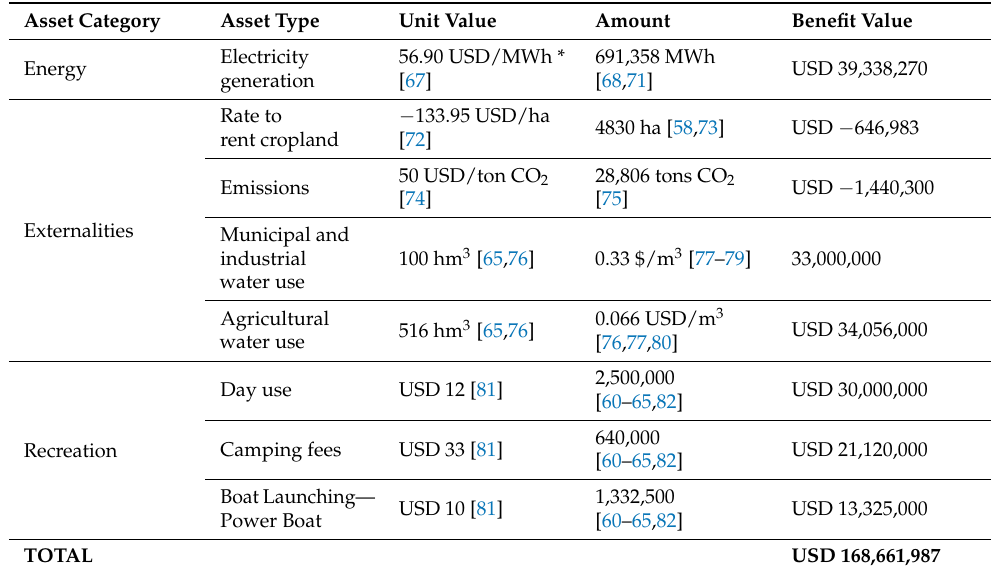
Table 3. Data used to assess the impact associated with the Folsom hydroelectric power plant